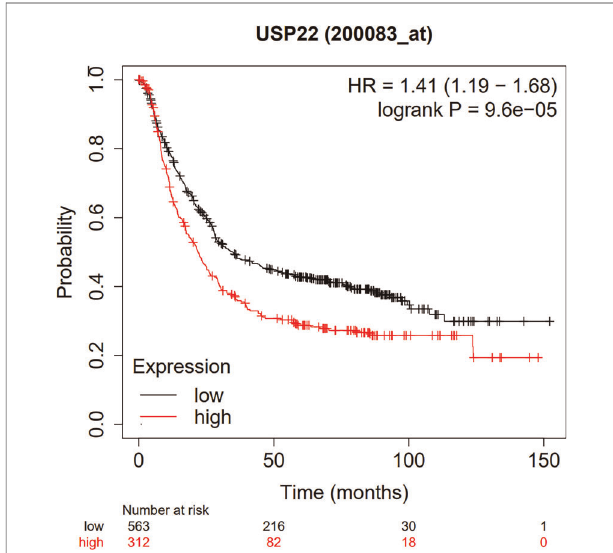
FIGURE 6 | Database validation to explore the relationship between USP22 expression and the OS of GC patients based on TCGA, GEO and